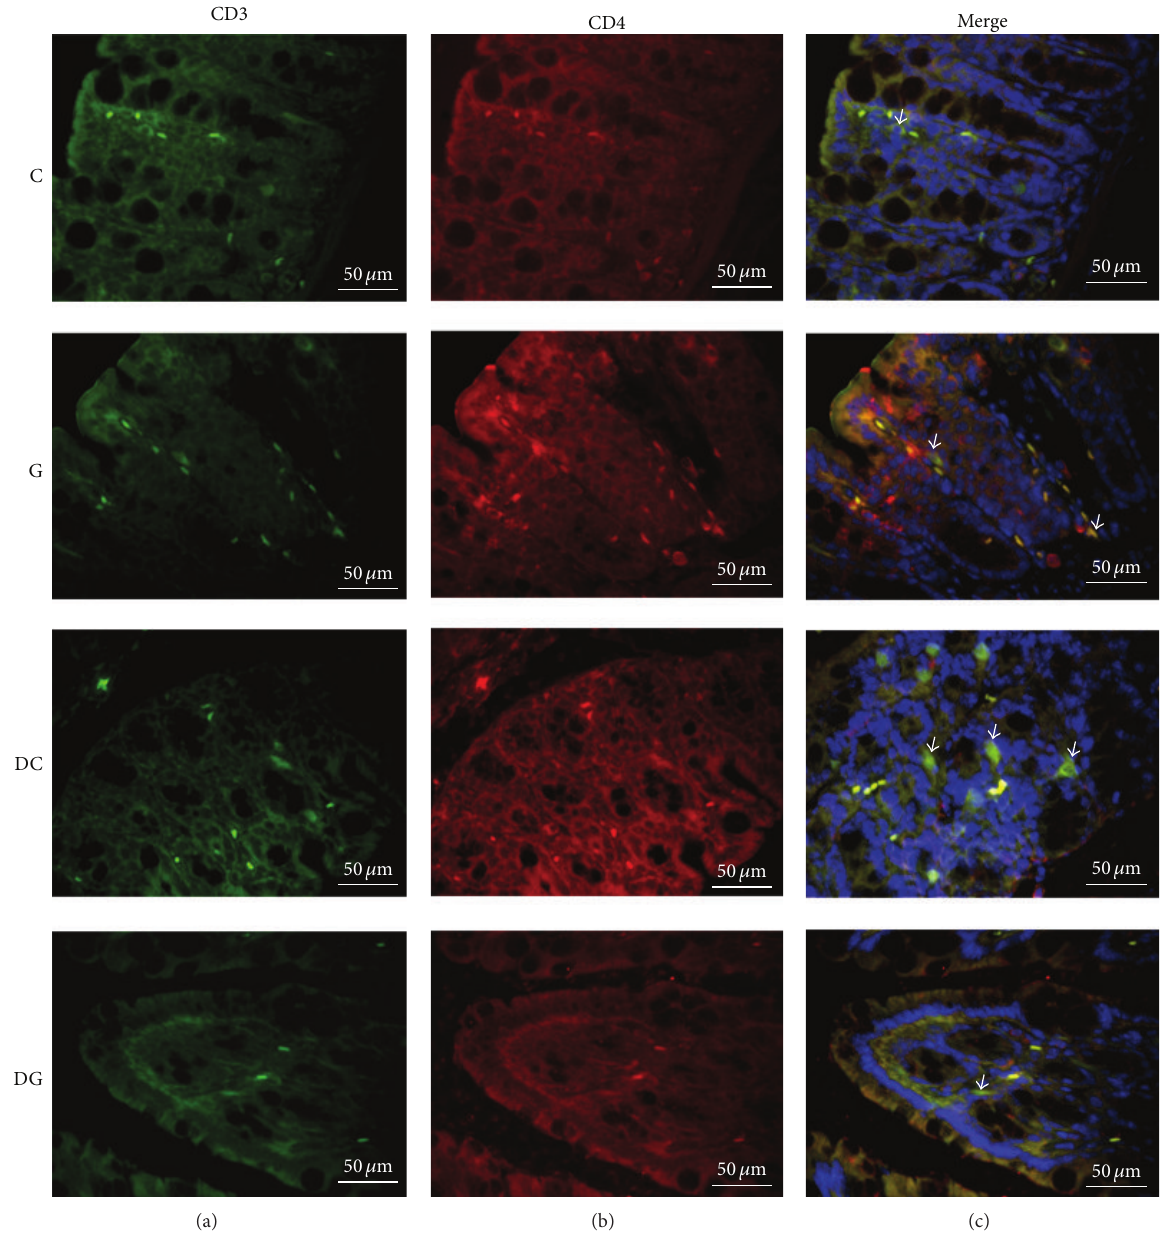
Figure 9: Representative examples of the immunofluorescence staining of T helper cells. In the left column, cell surface antigens were stained for CD3 (green, FITC), and staining of CD4 cells (red, rhodamine) is illustrated in the middle column. The nucleus is stained with DAPI (blue), and the last column presents a colocalized fluorescence image of CD3 + CD4 + T